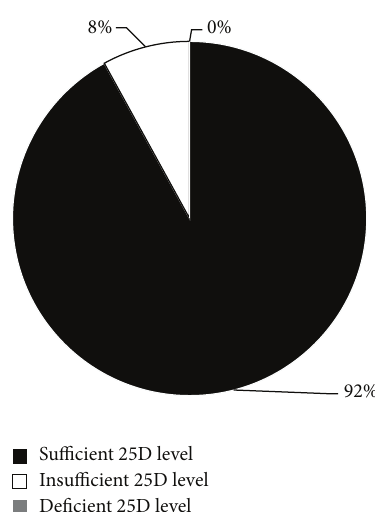
Figure3:ProportionofsubjectsontheGFCFdietwithdocumented 25(OH)D levels, with sufficient levels. In accordance with the Endocrine Society Practice guidelines [15], a sufficient level was considered to be ≥ 30 ng/mL, an insufficient level was considered to be between 21 and 29 ng/mL, and a deficient level was considered to be ≤